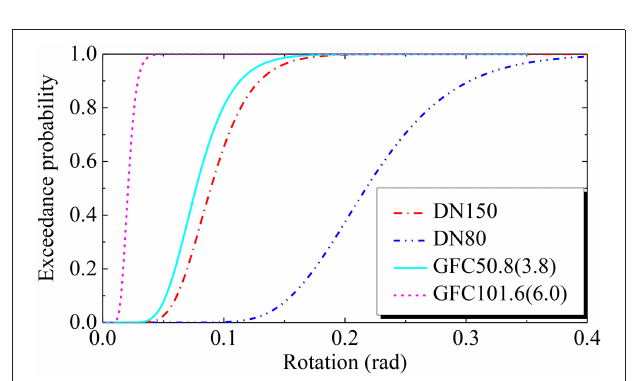
FIGURE 15 | Comparison of fragility curves of water leakage damage state for grooved fit